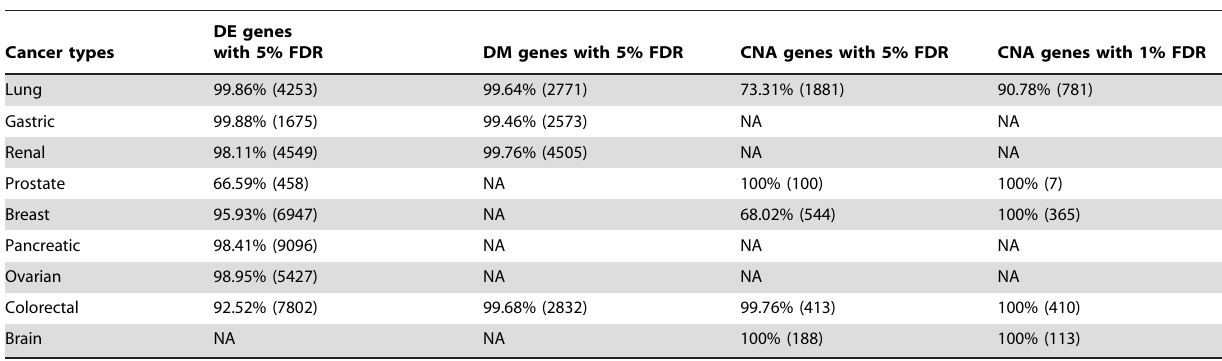
Table 1. Directional agreement of DE, DM and CNA